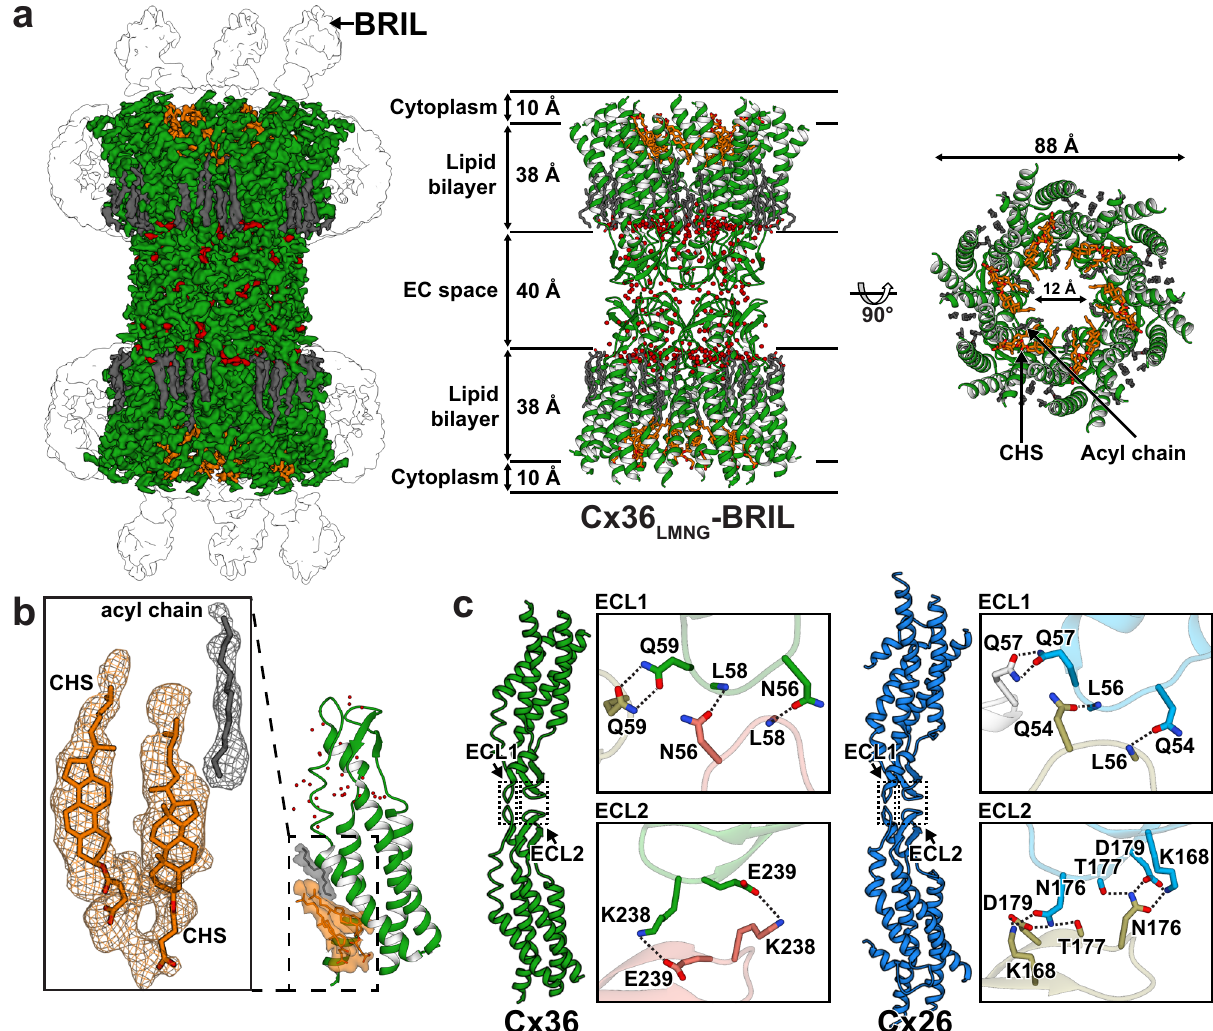
Fig. 1 | Overall structure and inter-hemichannel docking interface of human Cx36.a Cryo-EMreconstructionmapandribbonrepresentationofCx36 LMNG -BRIL. The density and atomic model of Cx36, CHS, acyl chain, and water molecules are colored green, orange, gray, and red, respectively. The ambiguous densities of detergentmicellesandBRILarecoloredwhite.Thesizeofeachpart oftheprotein (middle), the channel diameter, and the solvent-accessible pore diameter (right)